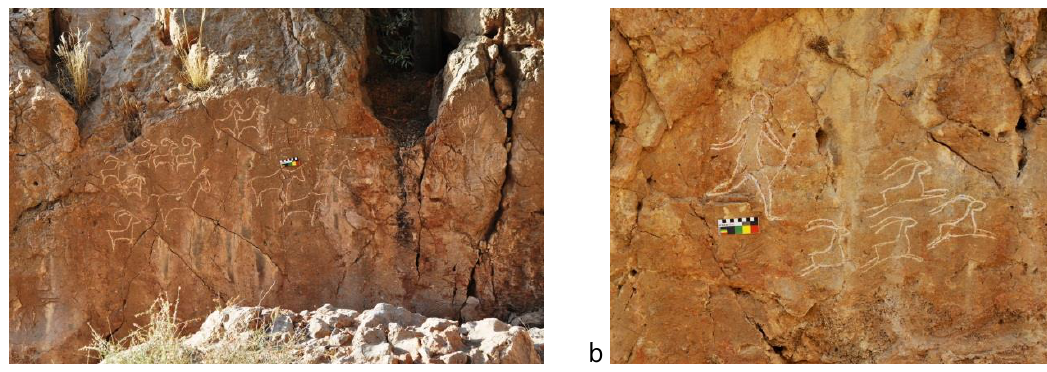
Figure 16. Site V. Engravings on the northern side of the